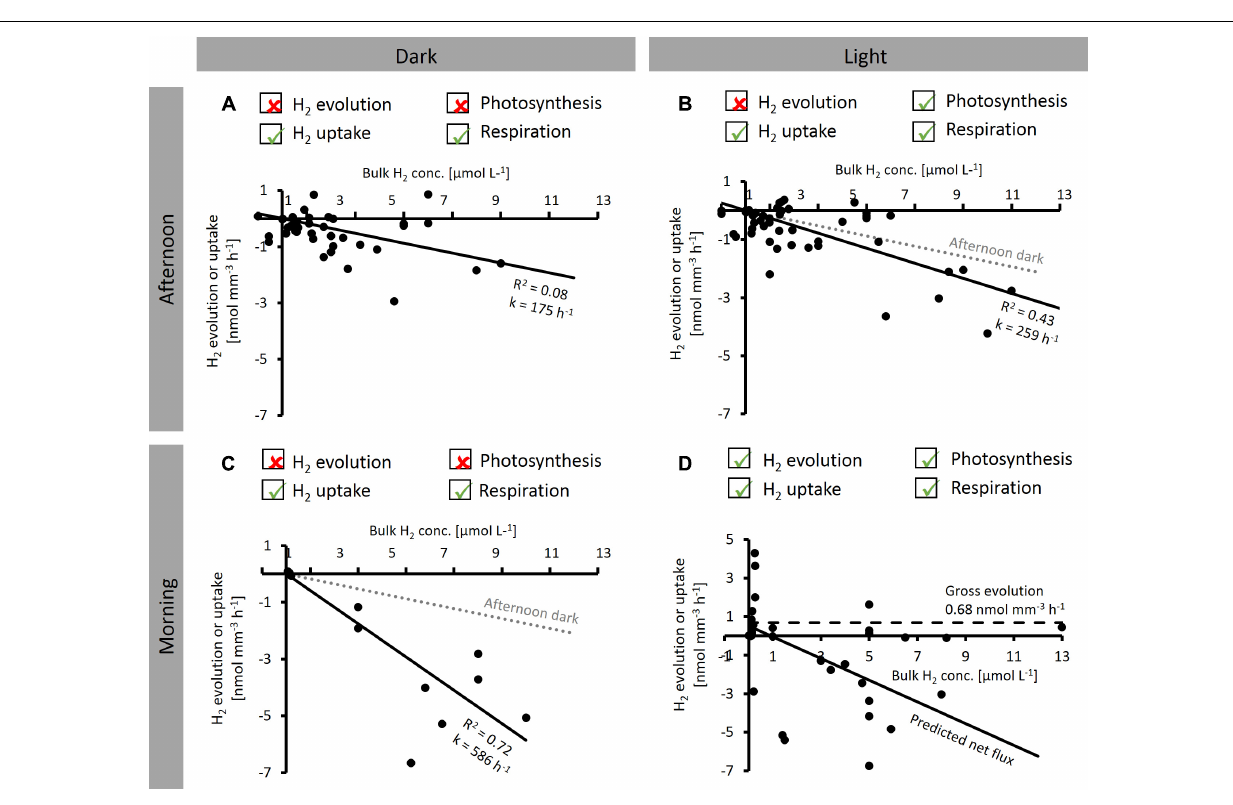
FIGURE 5 | Dependence of net H 2 evolution and uptake by Trichodesmium colonies on bulk H 2 concentration measured at different times of the day [before 2 pm (morning) and after 2 pm (afternoon)] and under different light conditions. Ticked boxes above the plots indicate the dominant H 2 and O 2 producing and consuming processes under each condition, as indicated by microsensor results from this study. (A–C) show linear regression lines ( y -axis intercept forced to zero). (D) Solid line shows predicted net H 2 flux, dashed line shows gross H 2 evolution, predicted as indicated in the text. Note that all data shown are net rates with positive numbers reflecting net evolution of H 2 by a specific colony, and negative numbers reflecting net uptake of H 2